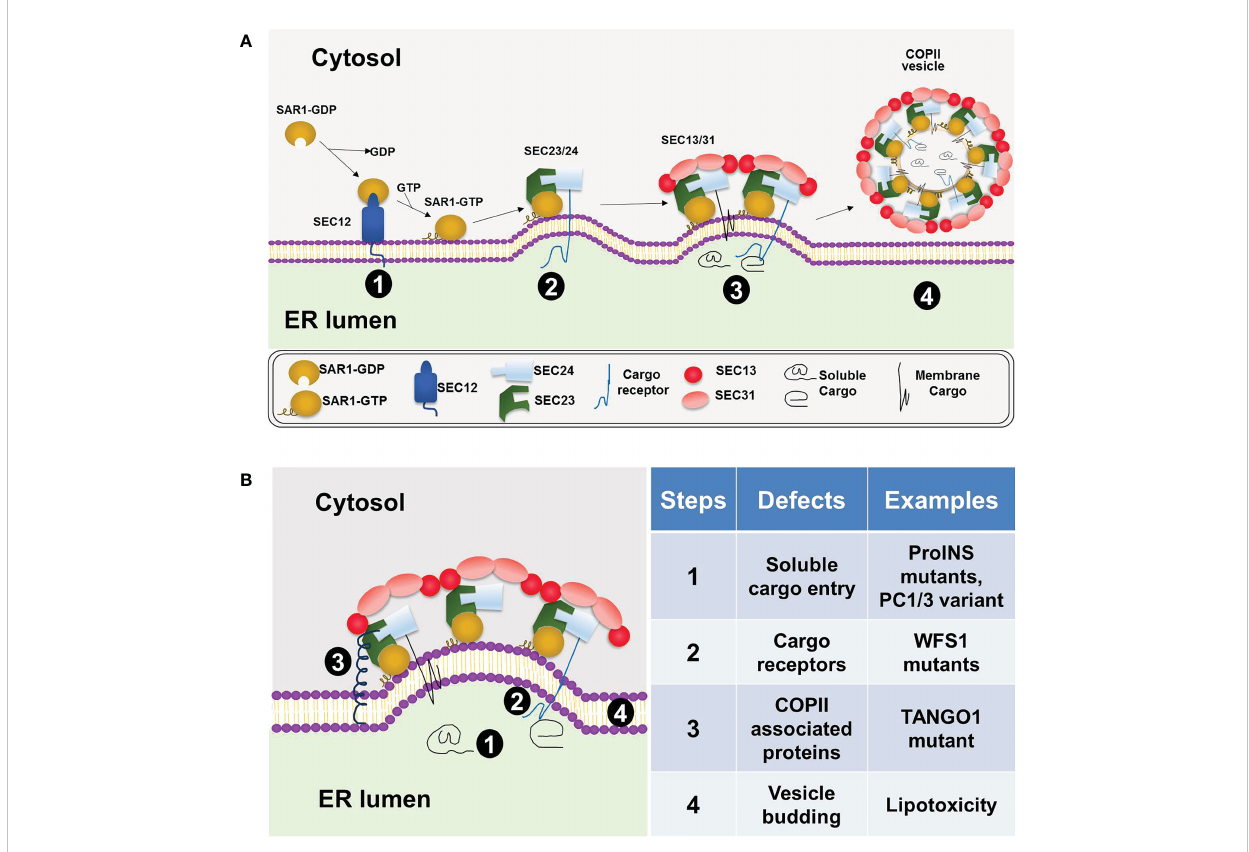
FIGURE 1 COPII coat assembly, cargo sorting, and vesicle formation at the ER. (A) A general model for COPII dependent ER exit in mammalian cells. COPII coat assembly on the ER membrane is initiated by SAR1 activation via SEC12 (stage 1), followed by the recruitment of the SEC23/SEC24 heterodimer and formation of the prebudding complex (stage 2). Next, the outer coat complex, SEC13/SEC31 heterotetramer, is recruited to bind the prebudding complex (stage 3). This step leads to further membrane deformation and vesicle formation. The vesicles coated with COPII proteins subsequently bud off the ER membrane (stage 4). (B) Defective ER export in beta cells under various diabetic conditions. Four different steps in the COPII- dependent ER exit process are highlighted on the left diagram and summarized with speci fi c examples on the right